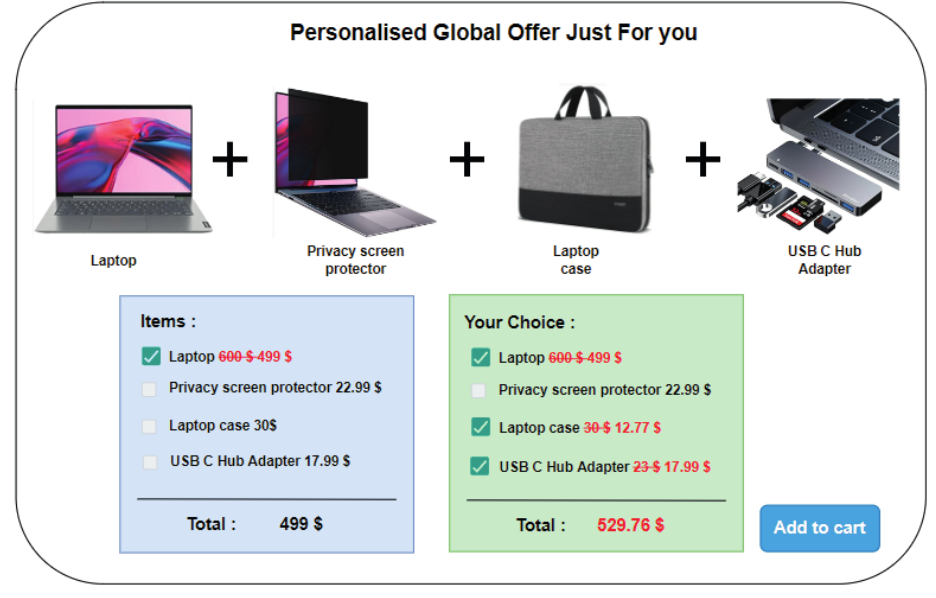
Fig. 7. Global offer